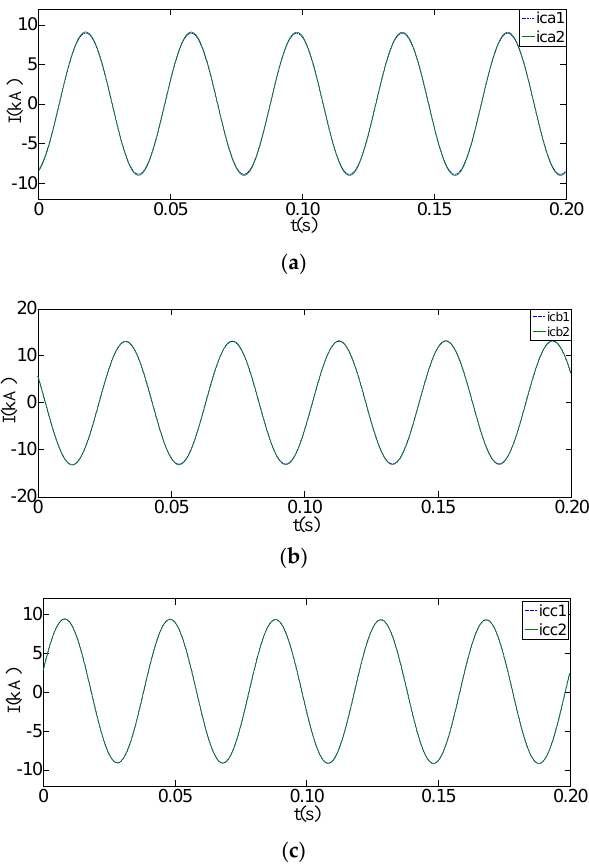
Figure 9. Waveforms of currents flowing through the GIL equivalent and simplified model: ( a ) Phase A currents; ( b ) Phase B currents; ( c ) Phase C currents.